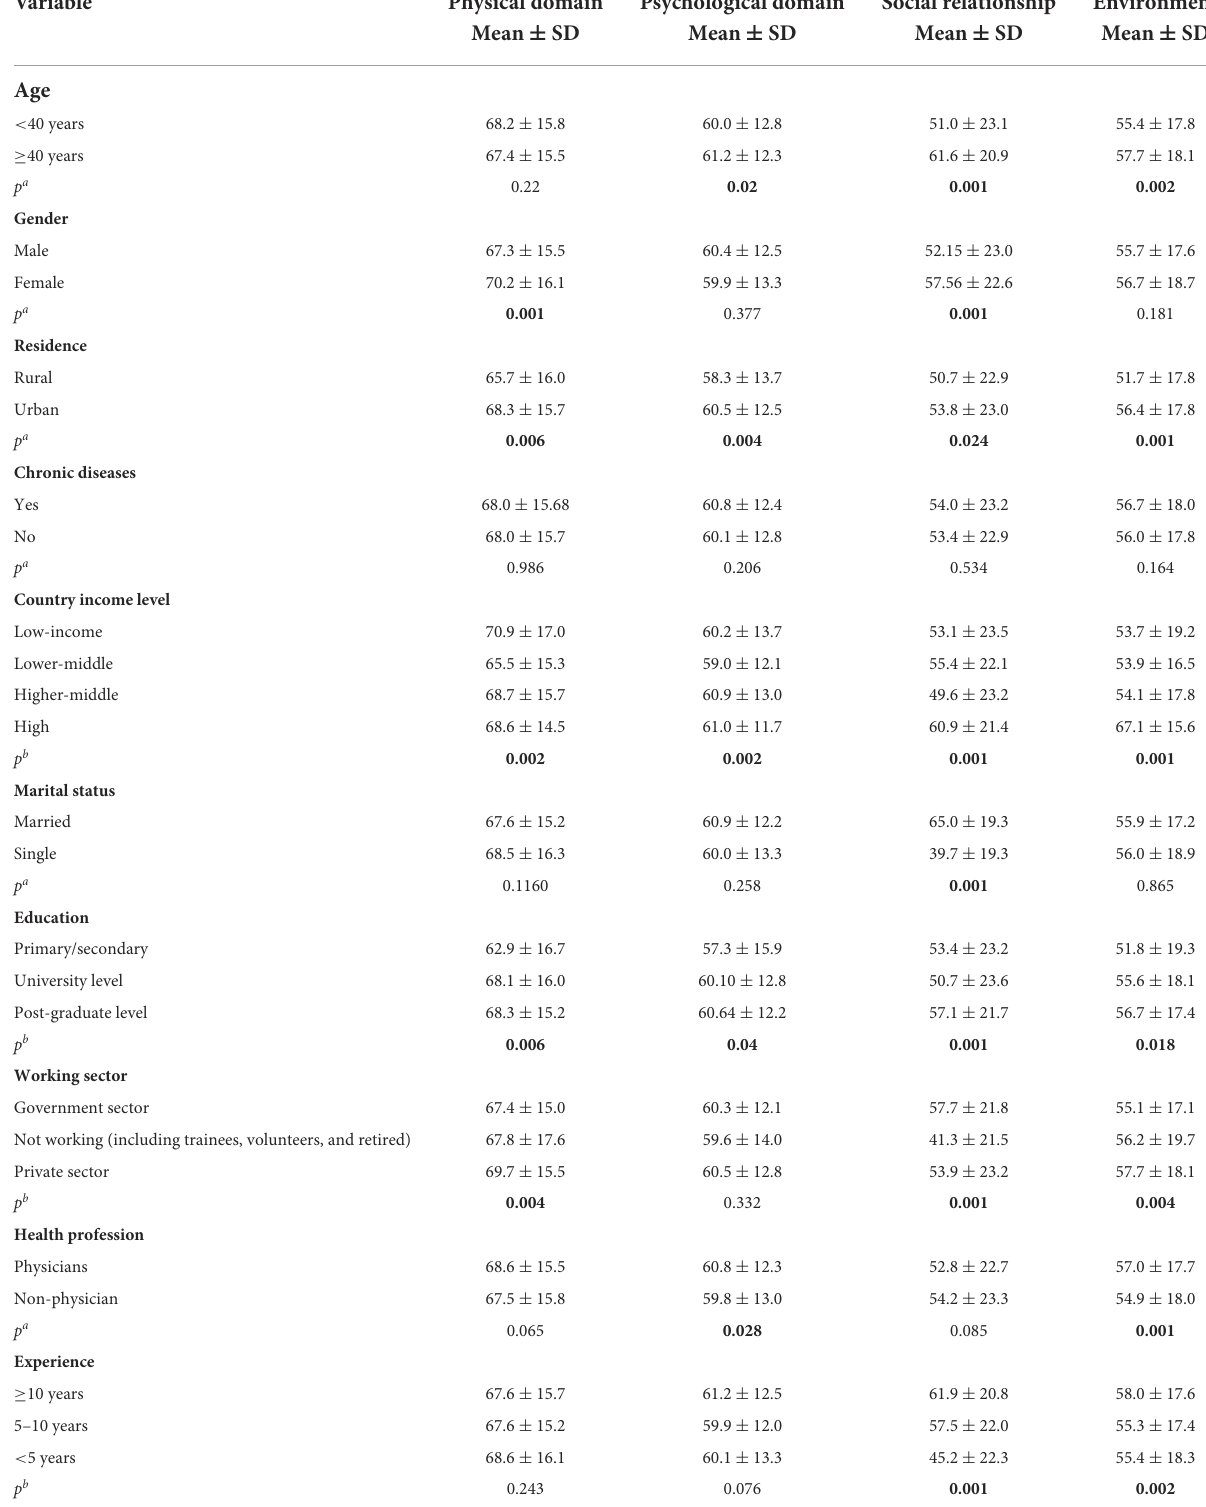
TABLE 4 Sociodemographic factors and quality of